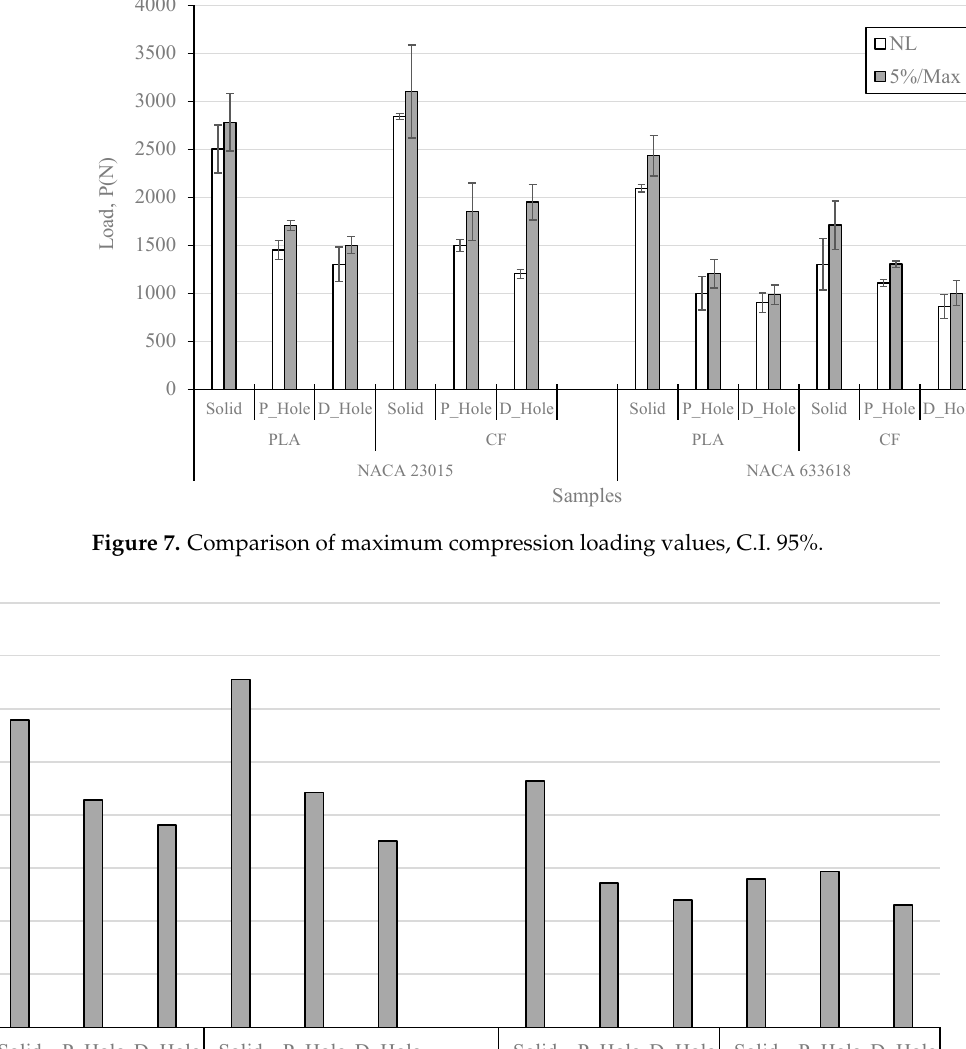
Figure 9. Von Mises stress distribution on PLA samples: ( a ) NACA 23015; ( b ) NACA 633618.